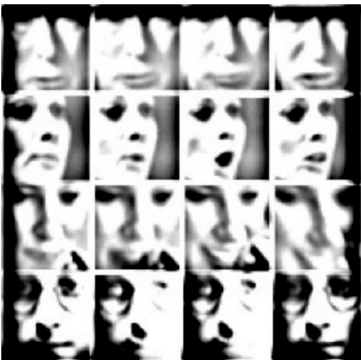
Figure 3. Complexity diversity of AFEW (Acted Facial Expressions in the wild) datasets.